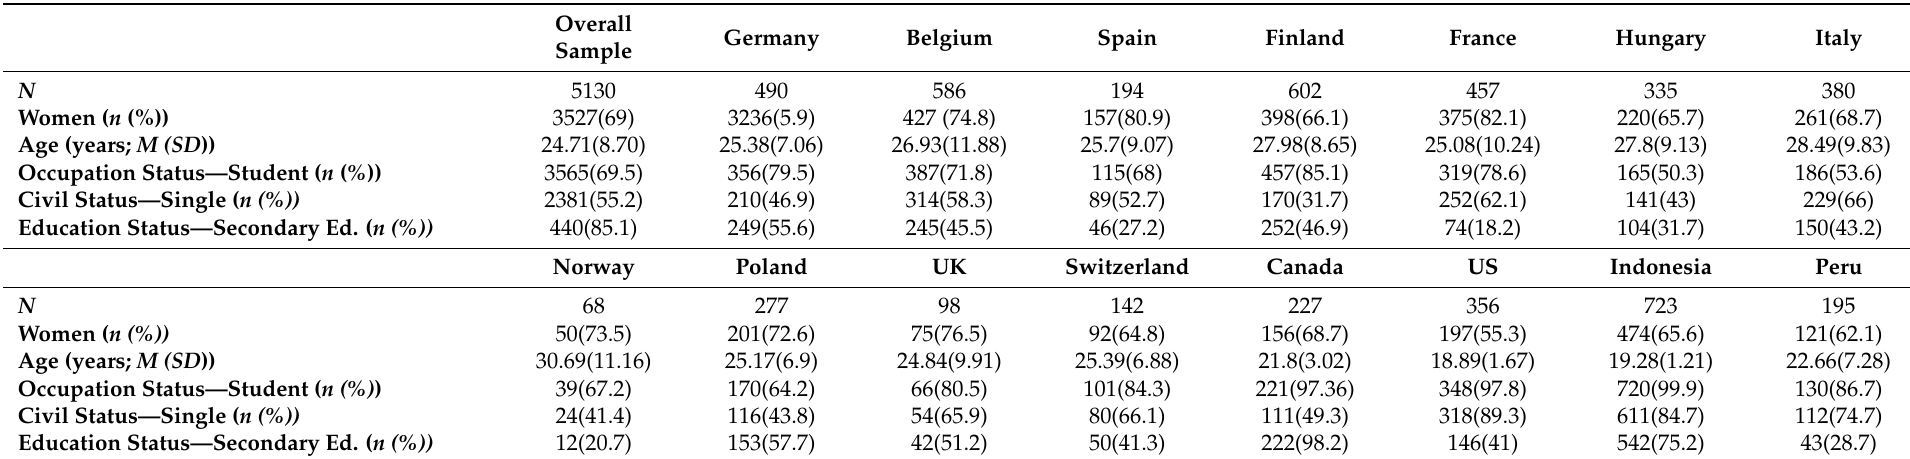
Table 1. Sociodemographic variables in each country.